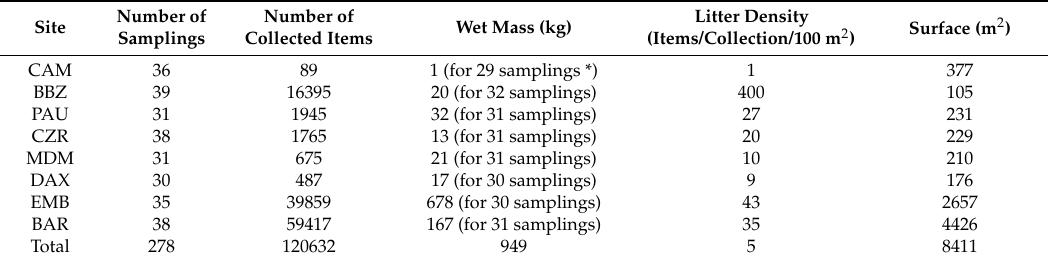
Table 2. Number of samplings, collected litter items and litter density for each